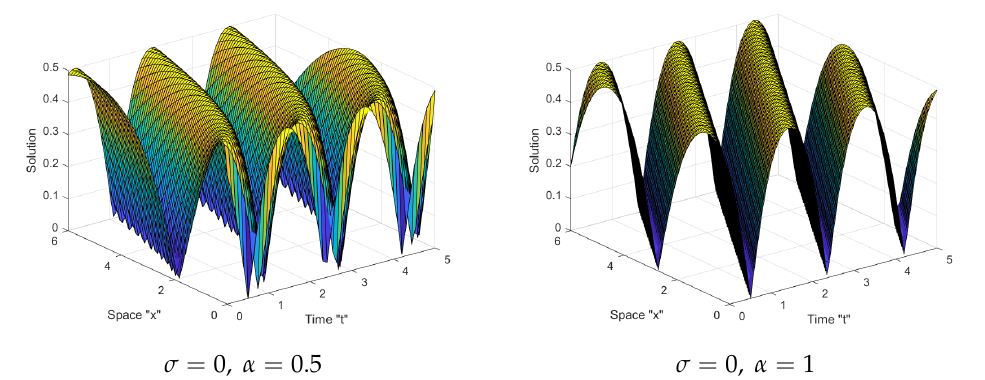
Figure 1. Three-dimensional plots of Equation (12).